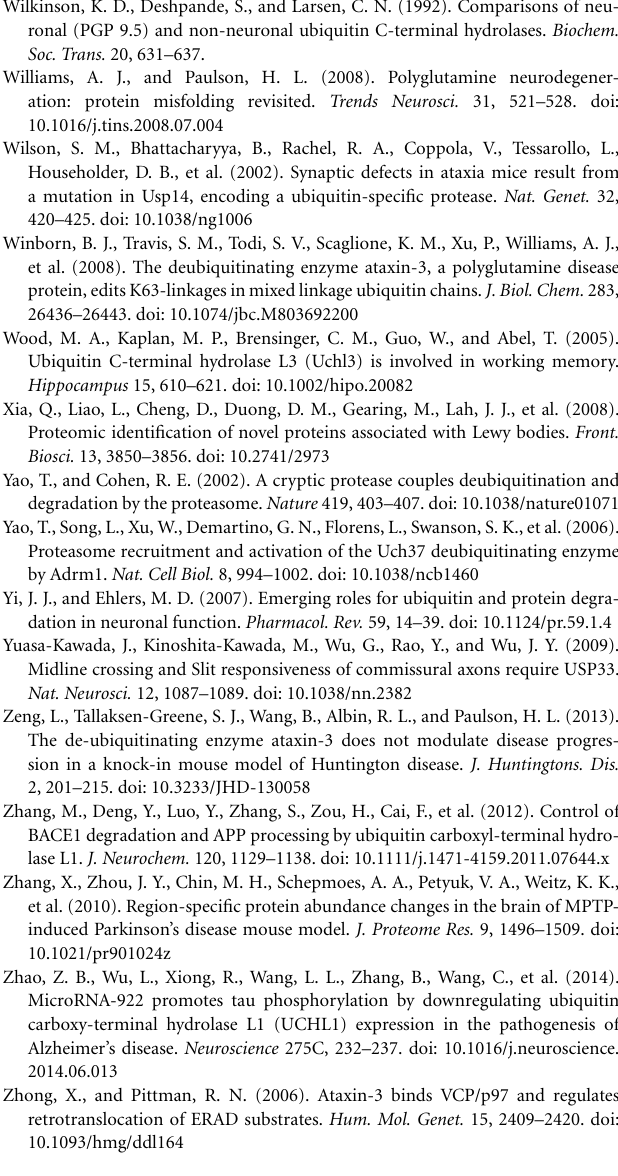
Figiel, M. (2011). Mouse ataxin-3 functional knock-out model. Neuromol. Med. 13, 54–65. doi: